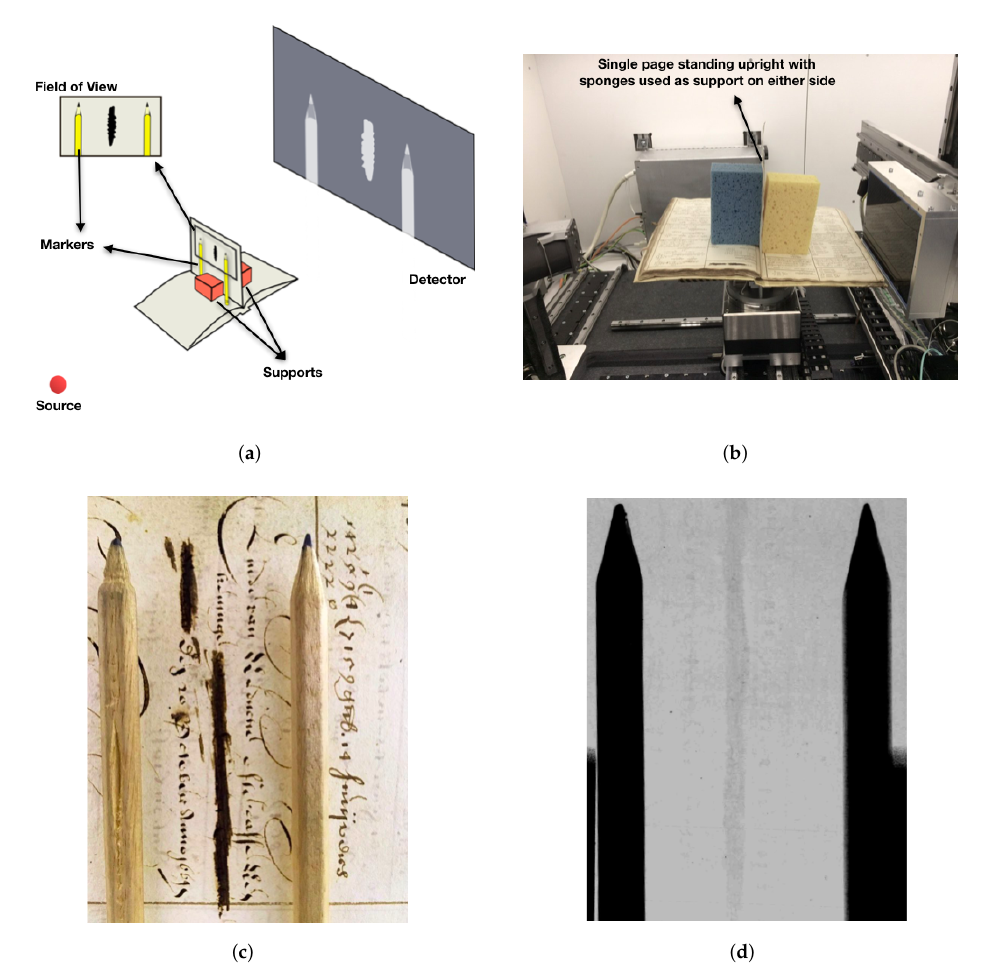
Figure 11. An illustration of the experimental setup is given in ( a ), with a photograph of the realisation inside the FleX-ray scanner in ( b ). An example field of view with a given magnification is shown in ( c ) with pencils used as markers, and the unprocessed radiograph of the same field of view in ( d ) with the sponges behind the scanned page acting as